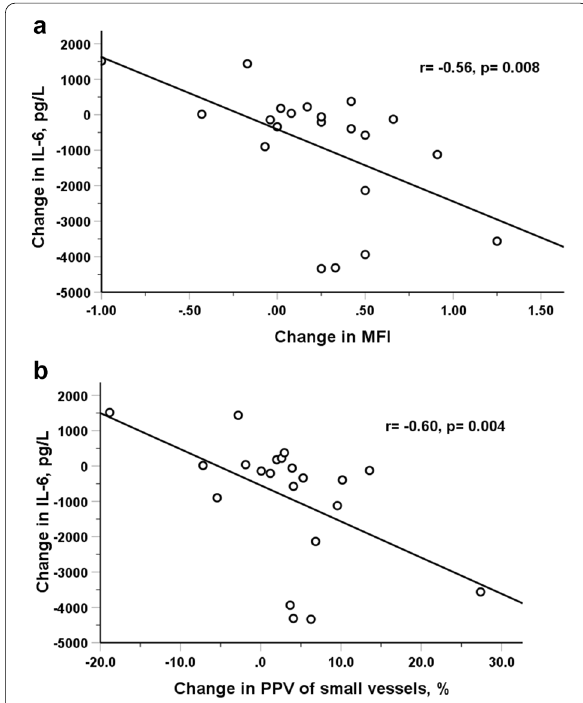
Fig. 2 Correlation of the change in IL-6 after 24 h with a microvascular flow index (MFI) and b proportion of perfused vessels (PPV) of small vessels during the first application of